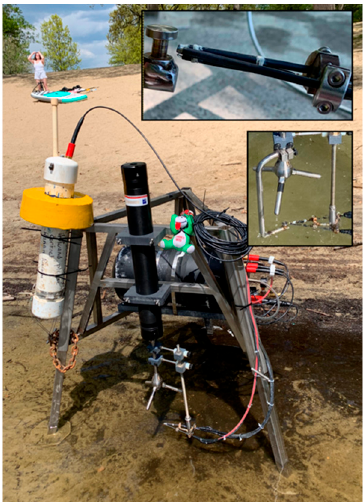
Figure 1. Eddy flux instrument mounted on benthic lander. Communication buoy, shown strapped to the lander for very shallow deployments, floats free for deeper deployments. ( Top inset ) FACT sensor head including optical fibers, conductivity electrodes, and thermistor. ( Bottom inset ) FACT sensing head shown with jig for aligning sensing volumes.